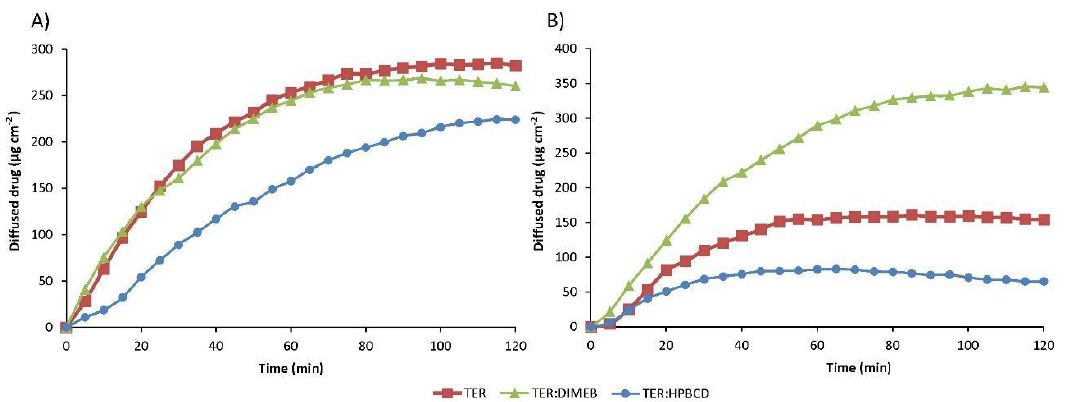
Figure 14. In vitro diffusion studies of TER and products in simulated intestinal fluid ( A ) and simulated gastric fluid ( B ).